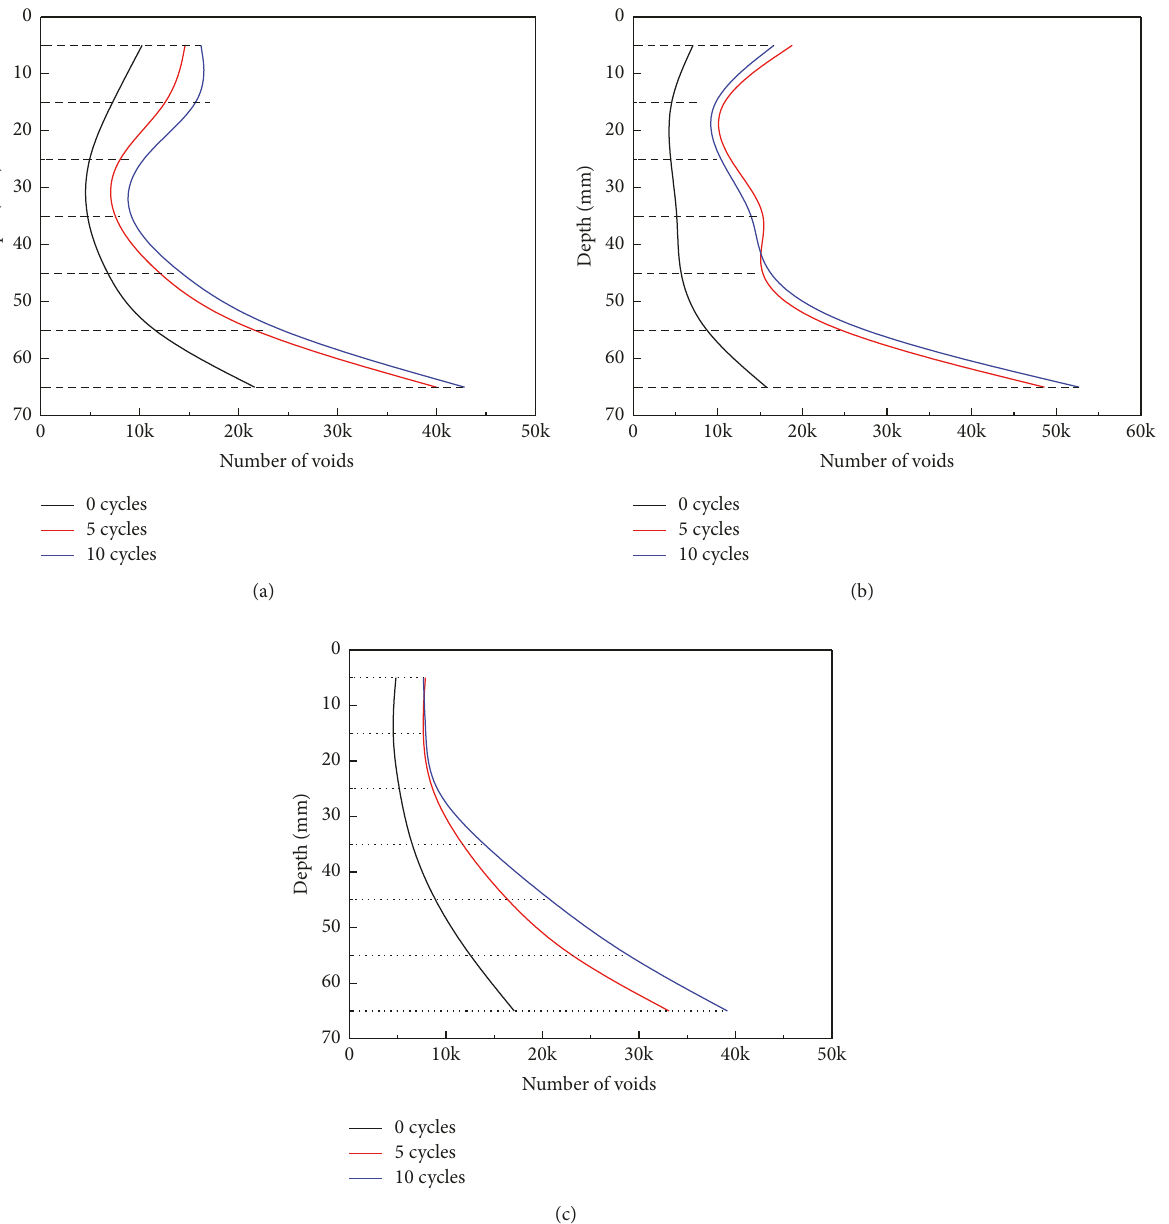
Figure 9: Void number distributions of different samples after 28 d of curing: (a) cement content = 4.0%; (b) cement content = 4.5%; (c) cement content =